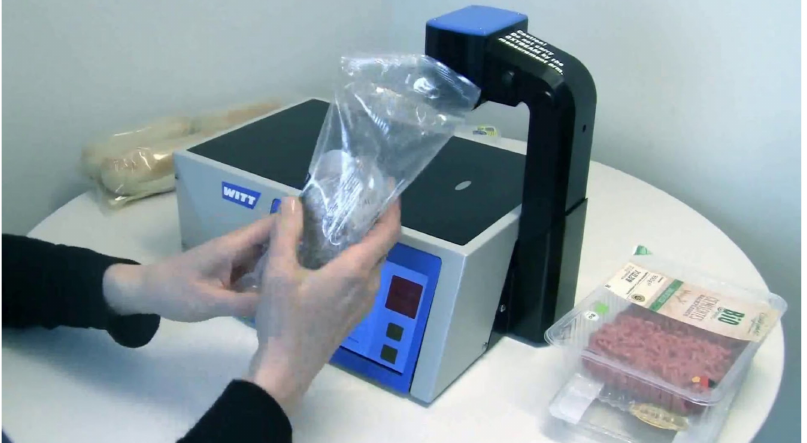
Figure 9. Non-destructive method of O 2 or CO 2 measurement by Oxybeam ®®® analyzer, reprinted with permission from WITT Polska.